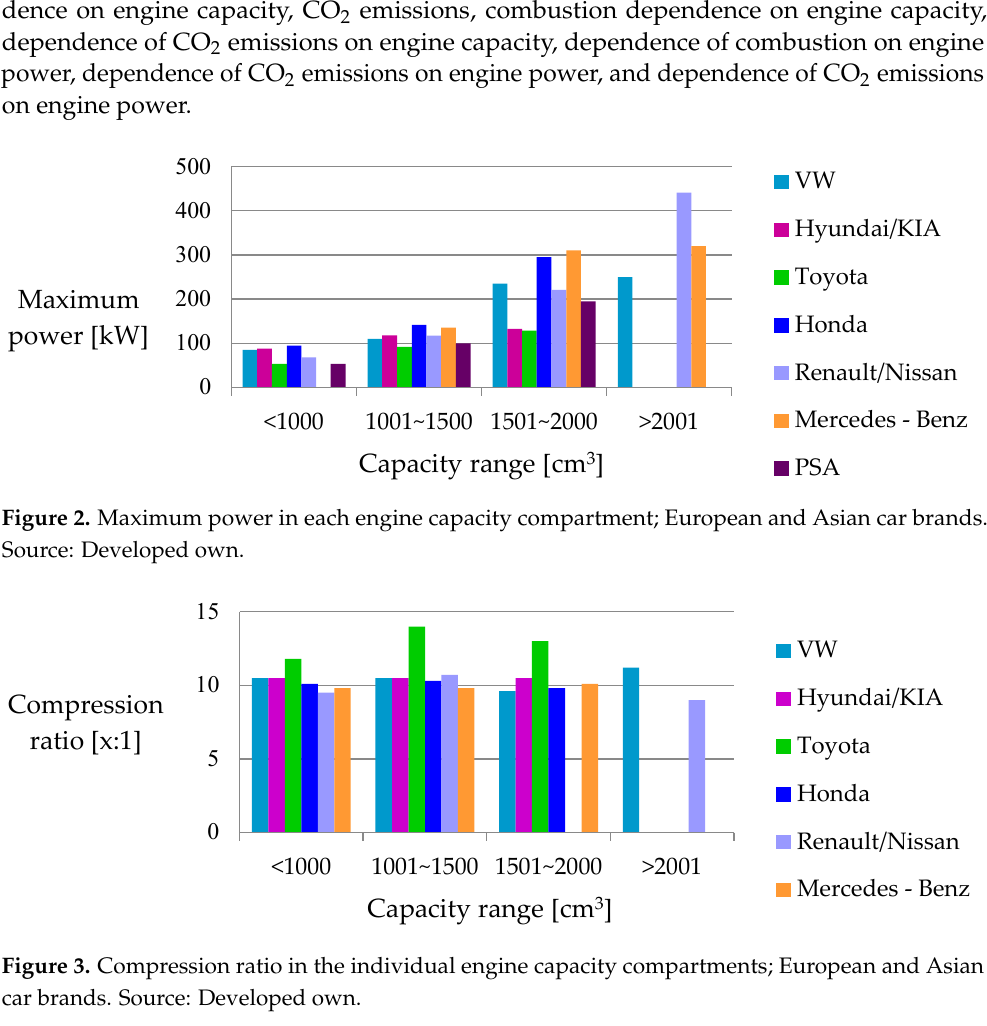
Figure 3. Compression ratio in the individual engine capacity compartments; European and Asian car brands. Source: Developed own.